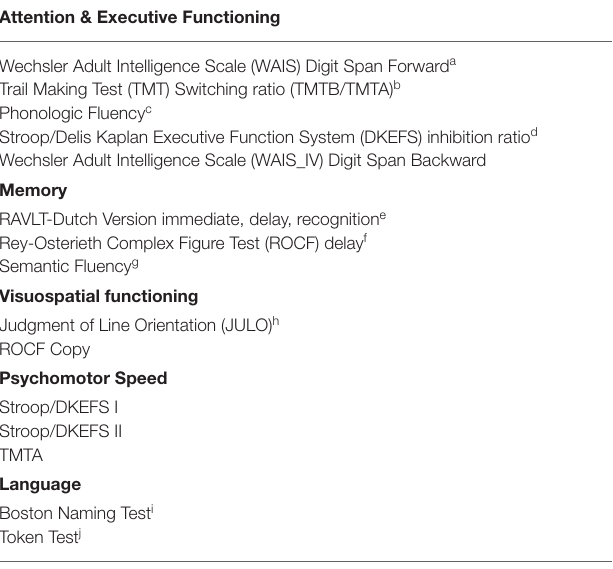
TABLE 1 | Neuropsychological tasks per domain. Attention & Executive